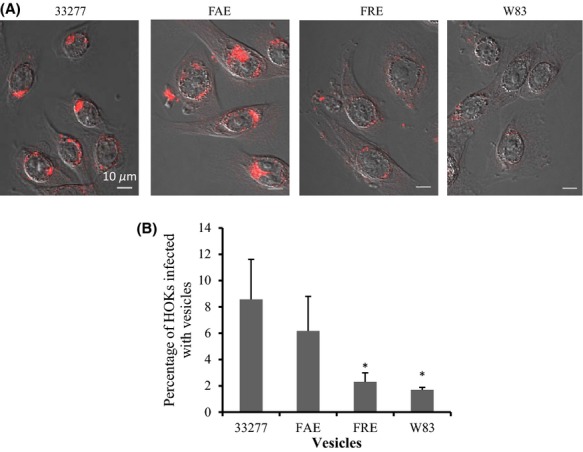
Invasive activity of Porphyromonas gingivalis vesicles into human oral keratinocytes (HOKs). (A) Vesicles derived from P. gingivalis 33277, fimA mutant (FAE), fimR mutant (FRE), or an afimbriated strain (W83) were added to transwells covered with a monolayer of HOKs. After a 24 h exposure, HOKs were collected by trypsinization and grown in a glass-bottomed dish for 24 h. Porphyromonas gingivalis vesicles were stained with Alex Fluor 546 (red) and observed under a confocal microscope. Infected cells are presented using differential interference contrast (DIC) images. (B) The percent of HOKs infected with vesicles was quantitated using FACS analysis. Data are shown as means ± standard deviations (n = 3). An asterisk indicates a significant difference between the percent of HOKs with internalized vesicles of P. gingivalis strains compared to those with 33277 vesicles (*P < 0.05 by t-test).